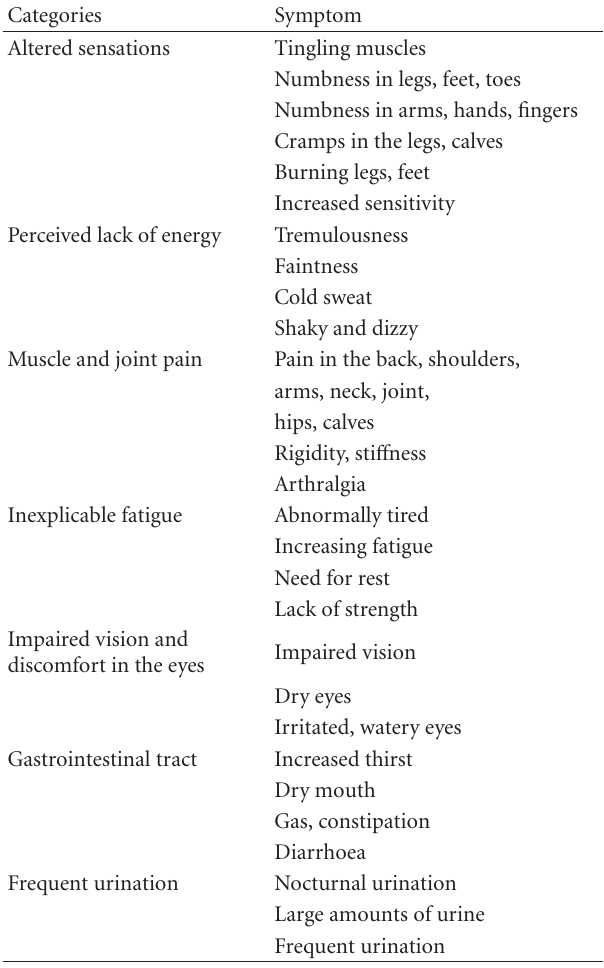
Table 2: Symptoms expressed by individuals with